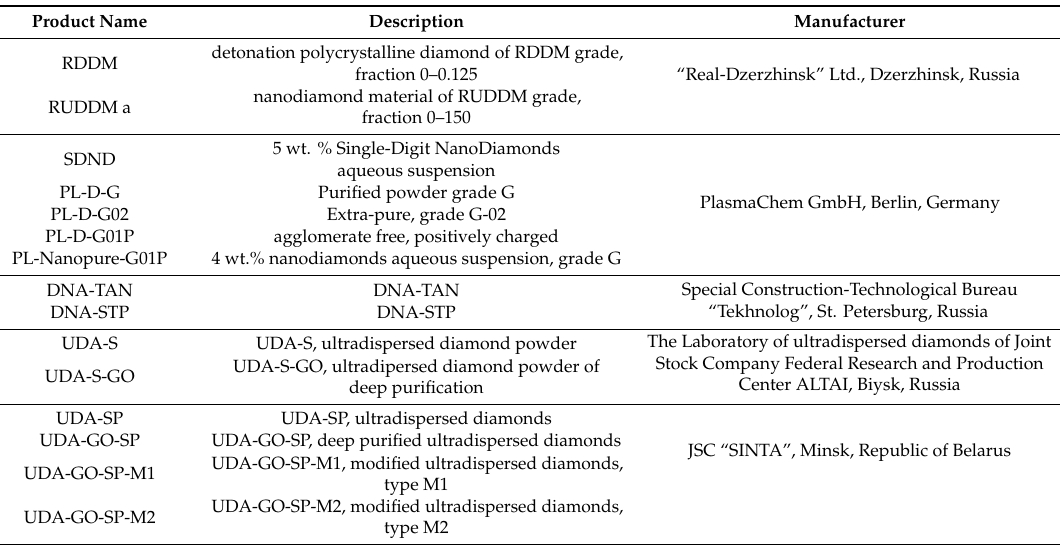
Table 1. Nanodiamonds used in the